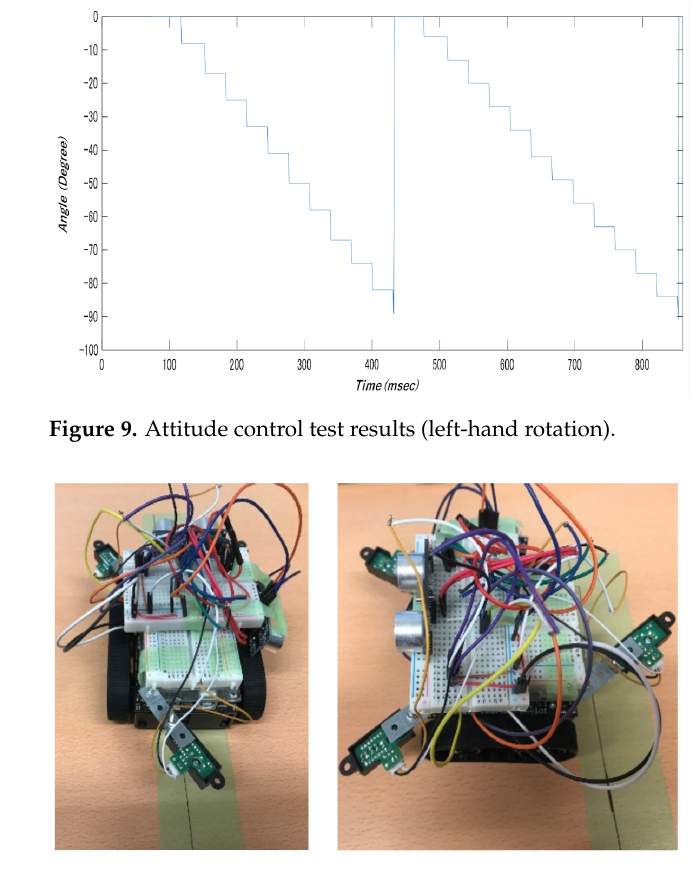
Figure 10. Robot prerotation ( left ) and postrotation ( right